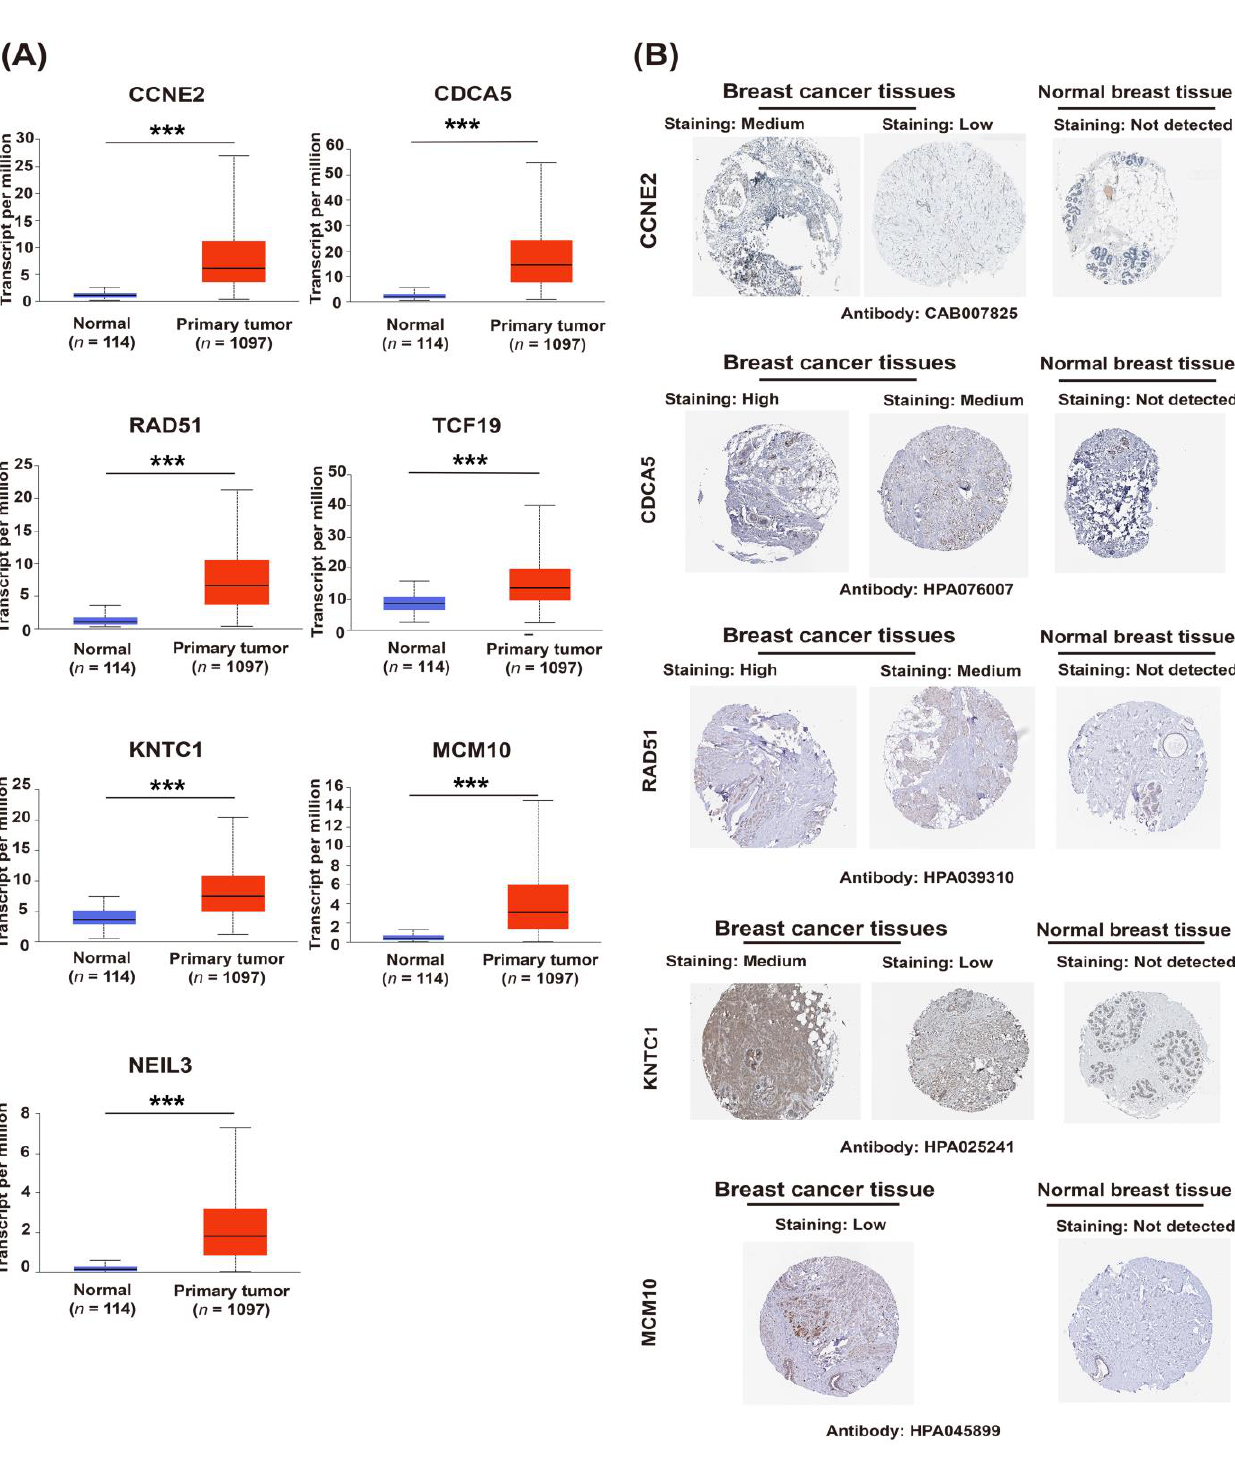
Figure 4. The upregulation of candidate genes ( CCNE2, CDCA5, RAD51, TCF19, KNTC1, MCM10, and NEIL3 ) is associated with breast tumorigenesis and malignant progression. ( A ) The gene expression of candidate genes in breast cancer tissues and corresponding adjacent breast tissues, based on the The Cancer Genome Atlas (TCGA) database and visualized by the UALCAN portal. * p < 0.05, ** p < 0.01, and *** p < 0.001. ( B ) Immunohistochemical results from the Human Protein Atlas (HPA) database. The protein expression of CCNE2, CDCA5, RAD51, KNTC1, and MCM10 in breast cancer tissues and normal breast tissue.